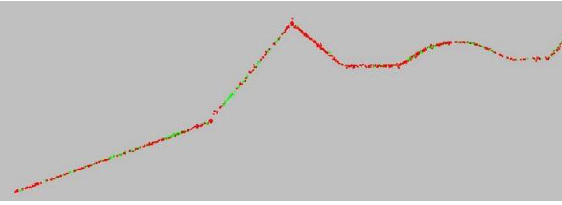
Figure 7. A profile of the reconstructed dense point cloud before (red color) and after (green color) applying the